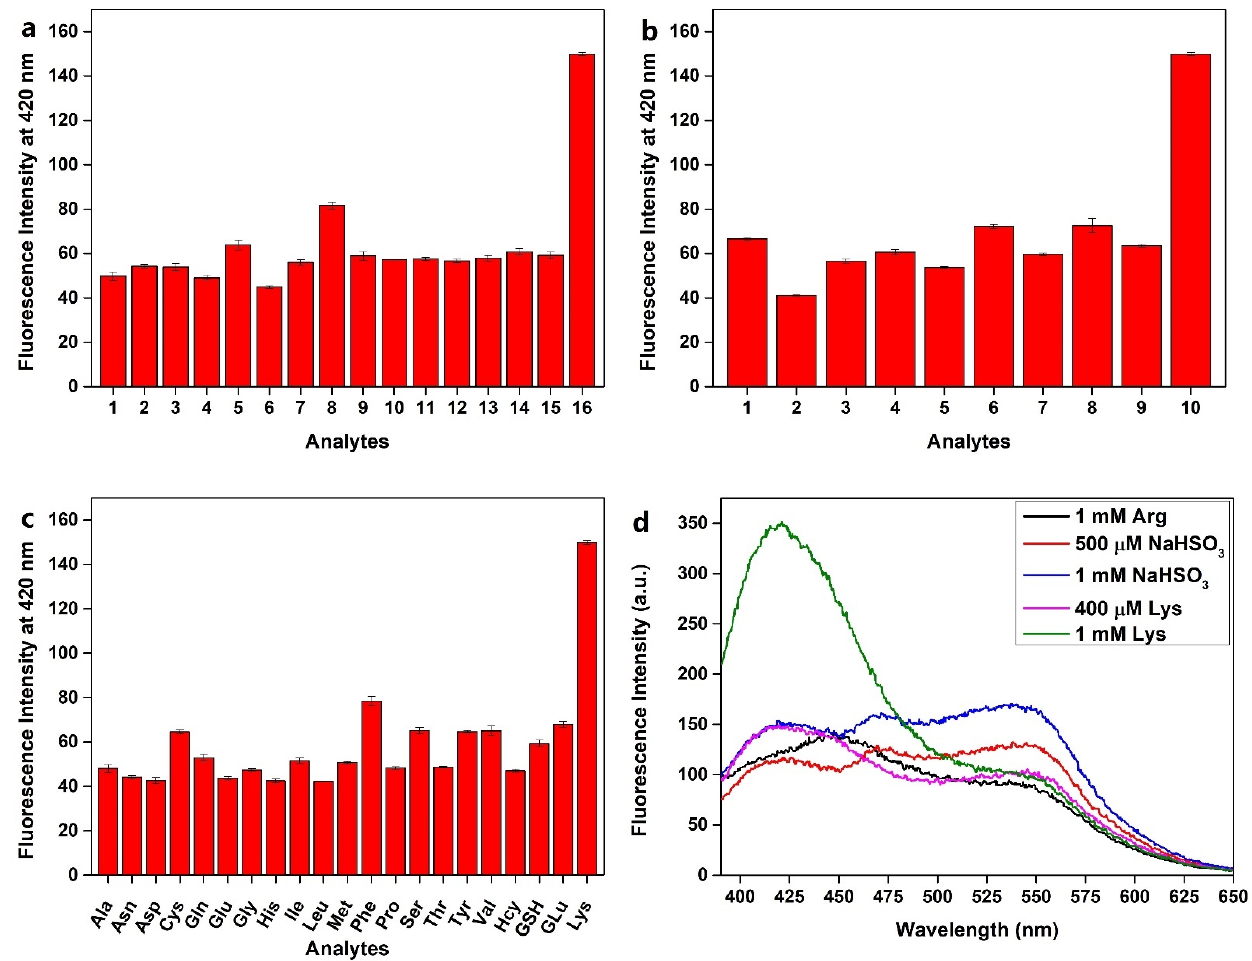
Figure 3. The selectivity of PQP ‐ 1 for Lys compared with various ions, Hcy, GSH, glucose (GLu), and other amino acids . ( a ) PQP ‐ 1 : 10 μ M, Lys: 400 μ M, other: 1 mM, (1) F − , (2) Cl − , (3) Br − , (4) I − , (5) NO 3 − , (6) NO 2 − , (7) HCO 3 − , (8) CO 32 − , (9) SO 42 − , (10) S 2 O 32 − , (11) S 2 − , (12) Ac − , (13) − OOCCOO − , (14) EDTA 2 − , (15) H 2 O 2 , (16) Lys; ( b ) PQP ‐ 1 : 10 μ M, Lys: 400 μ M, other: 1 mM, (1) K + , (2) Na + , (3) Ca + , (4) Ba 2+ , (5) Cu 2+ , (6) Mn 2+ , (7) Zn 2+ , (8) Mg 2+ , (9) NH 4+ , (10) Lys; ( c ) PQP ‐ 1 : 10 μ M, Lys: 400 μ M, other: 1 mM; ( d ) PQP ‐ 1 : 10 μ M.